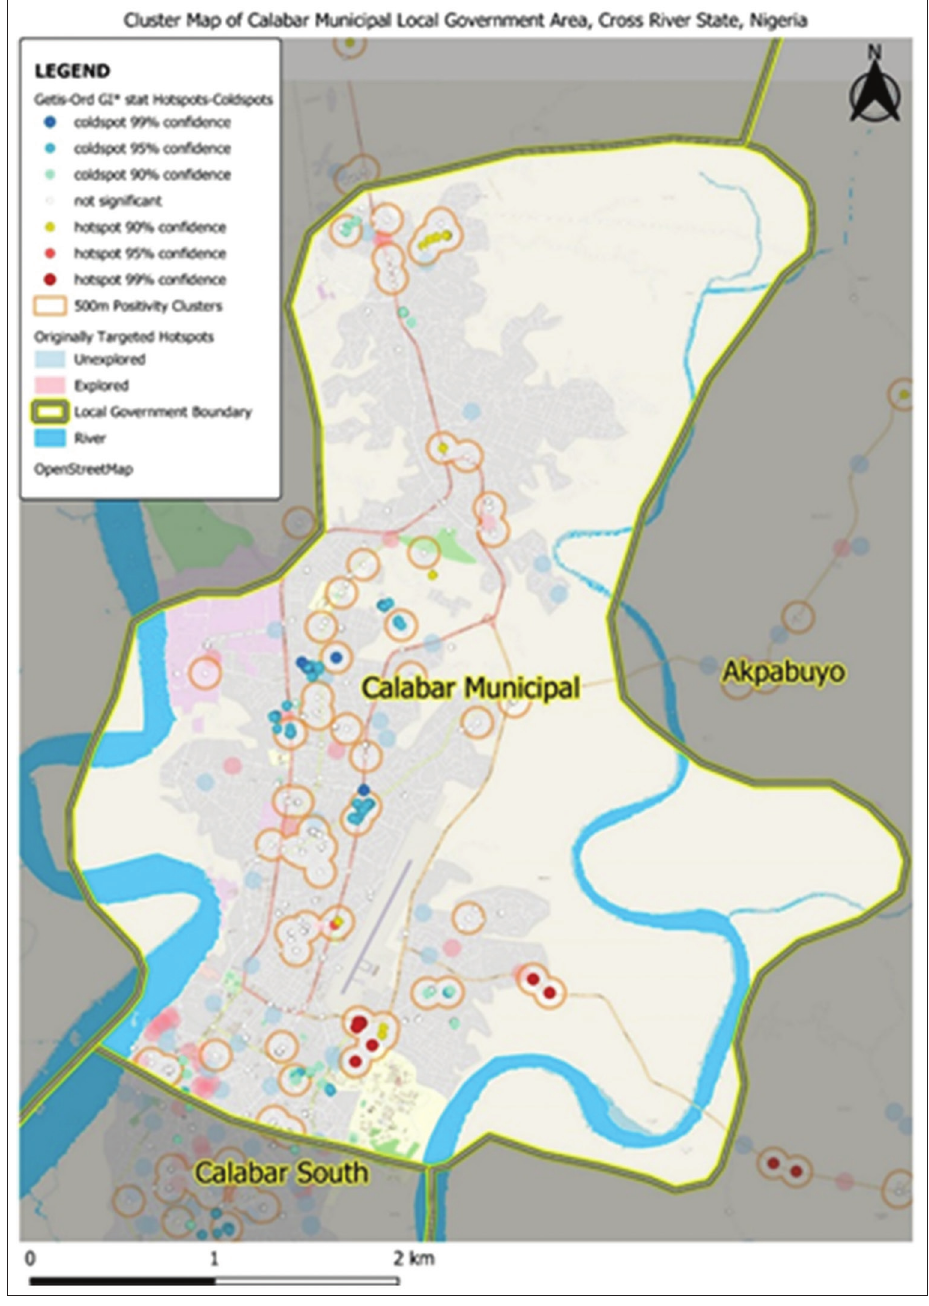
FIGURE 3. Sample cluster map of Calabar municipal LGA, Cross River State,